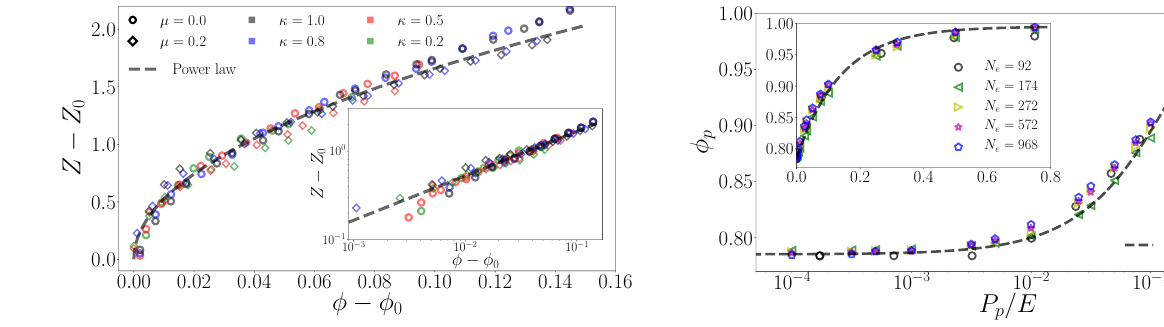
Figure 4. The reduced coordination number Z − Z 0 as a function of the reduced solid fraction φ − φ 0 for all the values of κ and µ simulated. The dashed line is the power-law relation Z − Z 0 = ξ ( φ − φ 0 ) α .